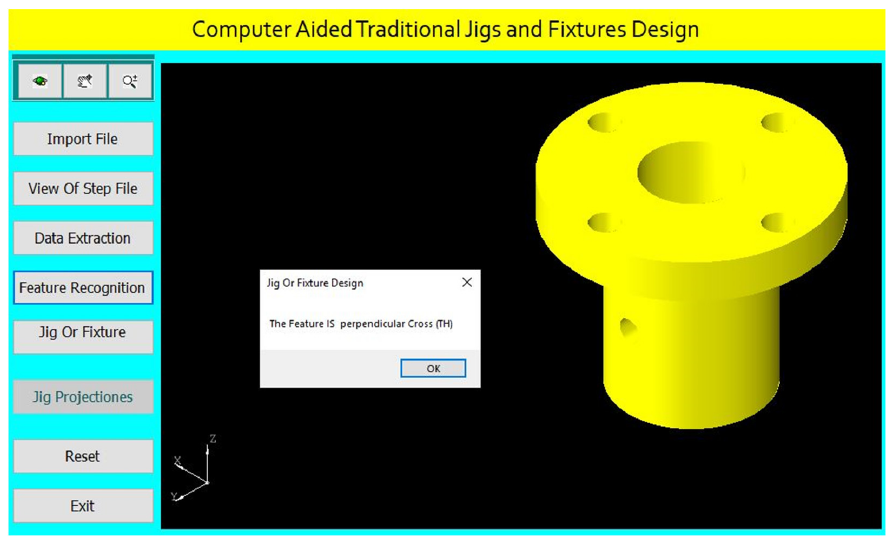
Figure 41. Automatic feature recognition of a perpendicular cross through-hole.